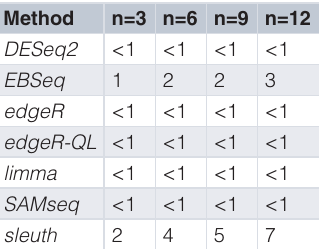
Table 2. Compute time of methods for differential gene expression (DGE) rounded to the minute by per-group sample size. Compute